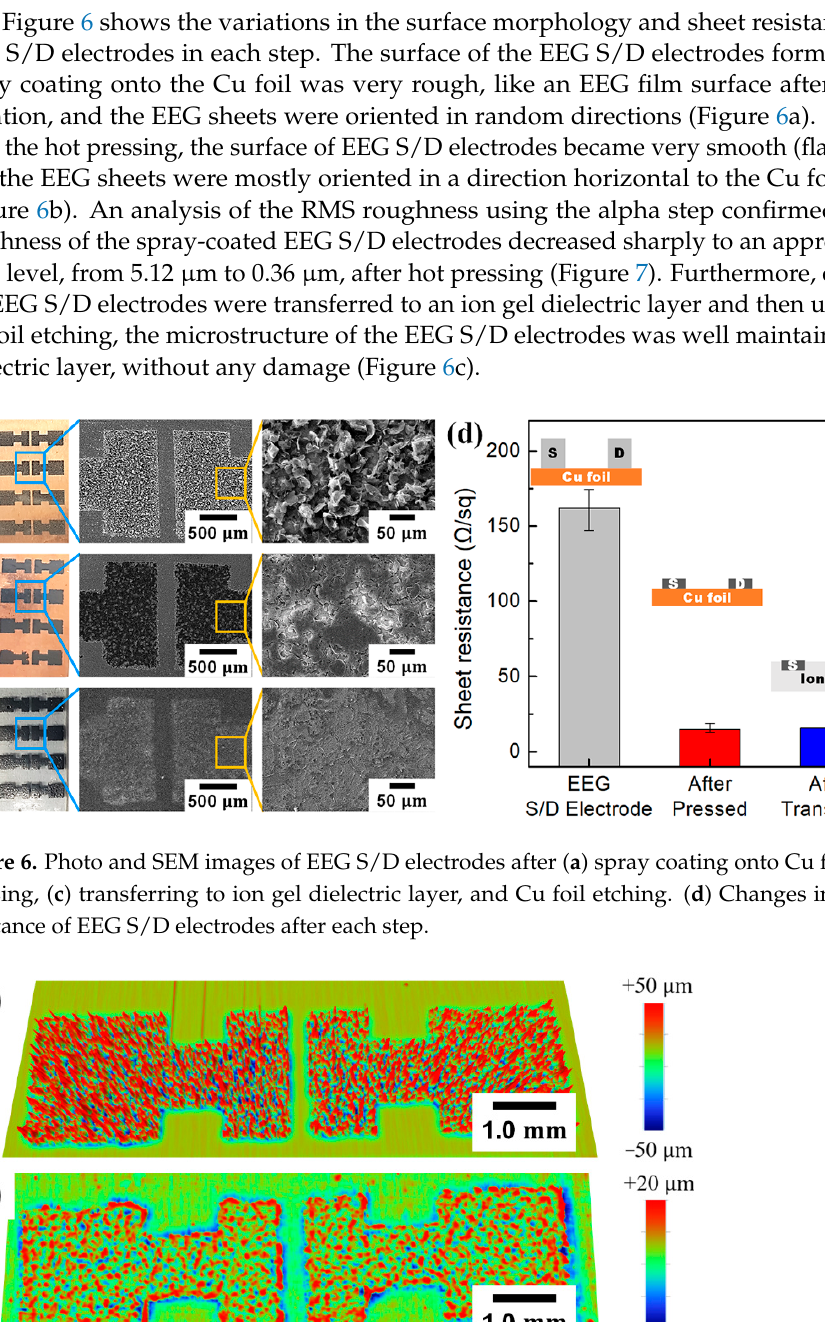
Figure 5. Photo images of the manufacturing process of the hot-pressed EEG S/D electrodes via transferring to the ion gel dielectric layer and Cu foil etching.